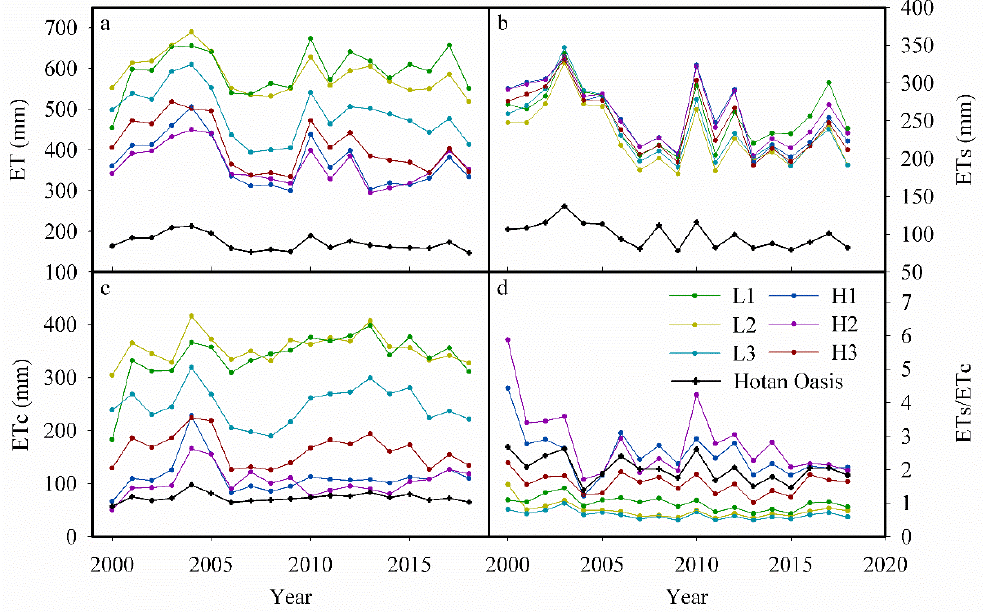
Figure 6. Relationship between the fragmentation and ET components. Figure ( a – d ) describe the ET, ETs, Etc, and Ets/Etc of Hotan Oasis and different fragmentation plots from 2000 to 2018, re-